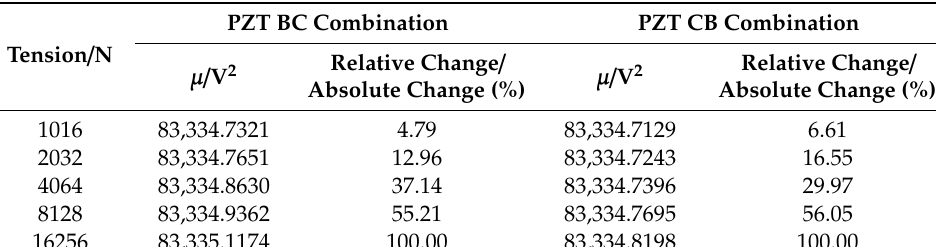
Table 3. Tests results of PZT BC combinations.